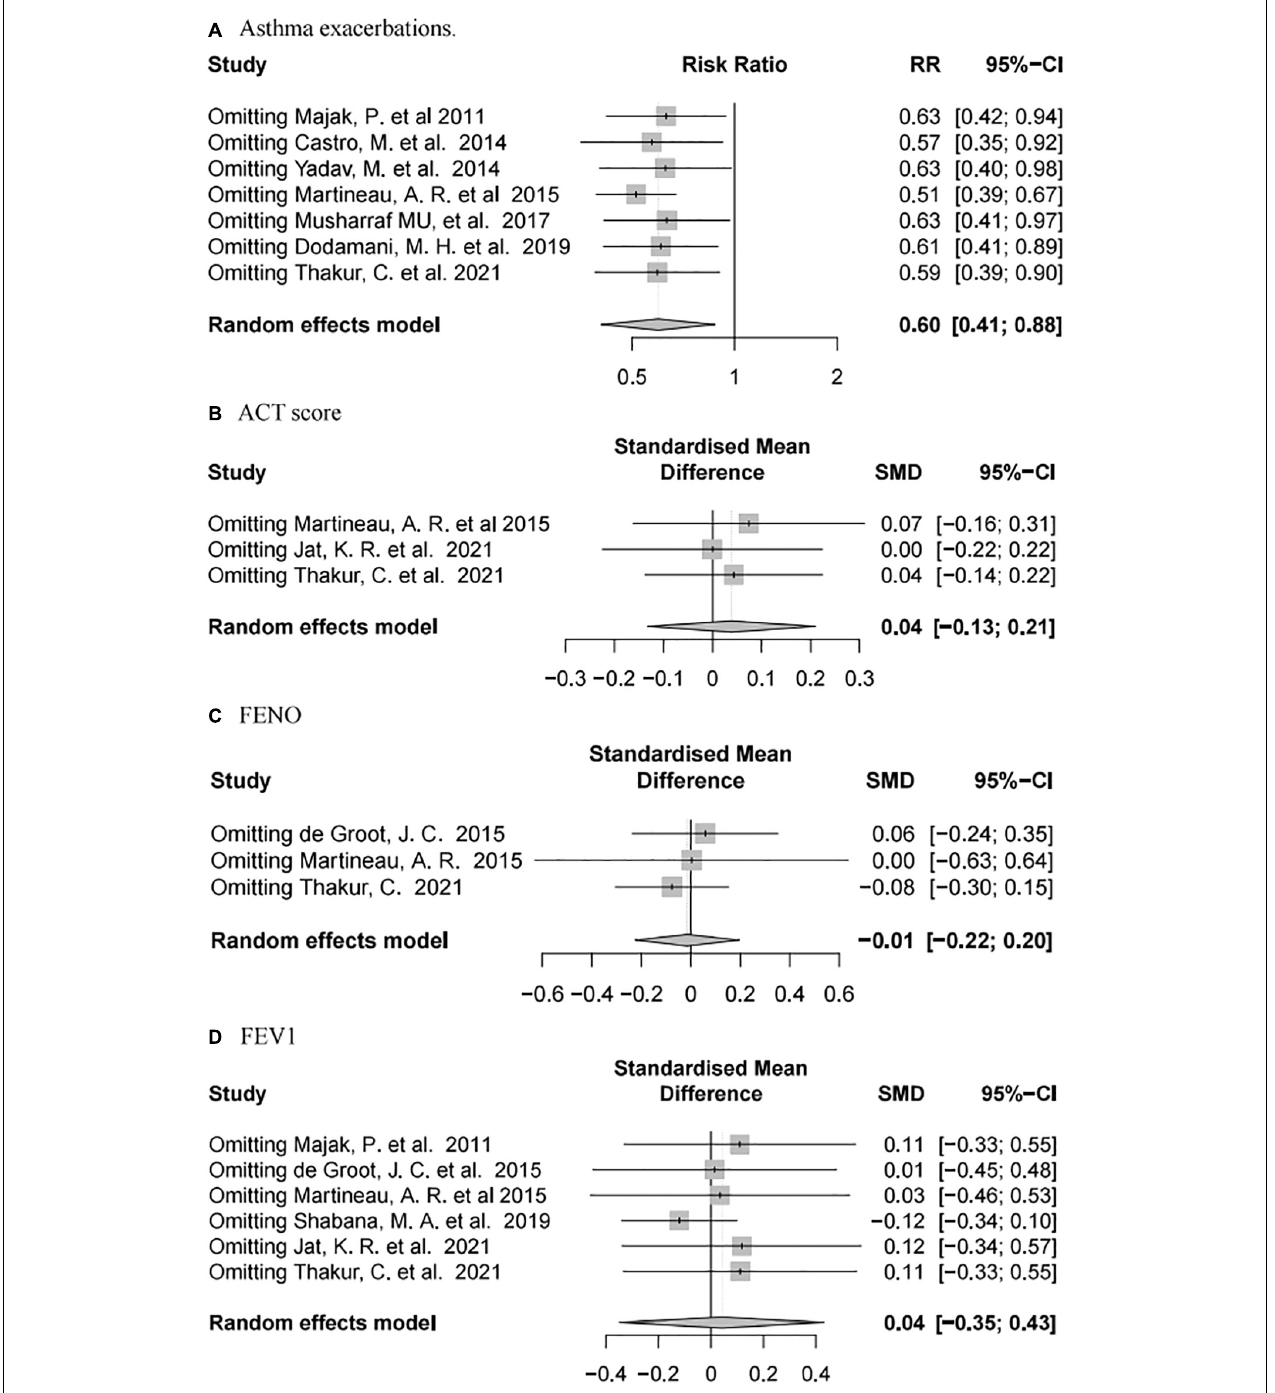
FIGURE 7 | Forest plot random effect model of sensitivity analysis for vitamin D supplementation for various